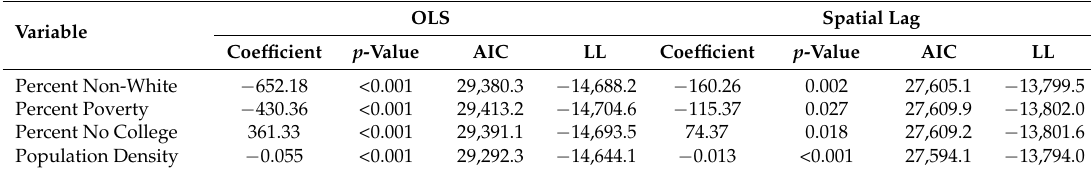
Table 2. Results of the OLS and spatial lag bivariate regressions spatial multivariable regressions indicating the relationship between swine AU density and EJ variables and population density in CBGs without considering the influence of other covariates. AIC = Akaike Information Criterion (smaller = better fit); LL = log likelihood (larger = better fit).